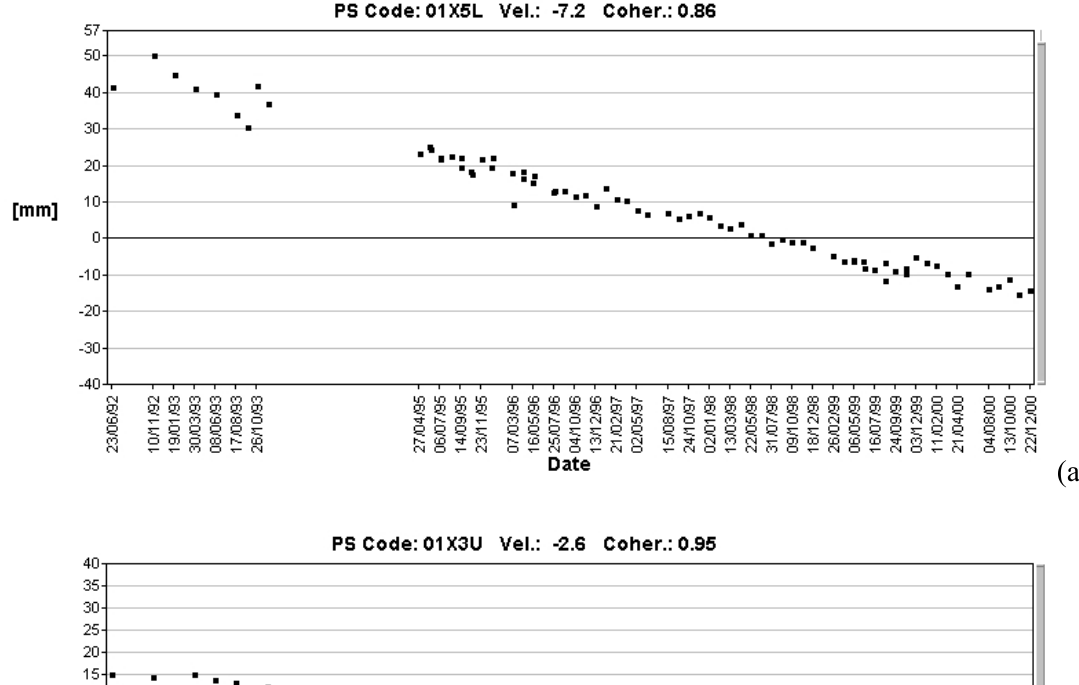
Figure 15. (a) PS LOS displacement series in correspondence of the highway. (b) PS LOS displacement series in correspondence of the lower sector of the Strona Stream alluvial fan. (c) PS LOS displacement series in correspondence of new buildings. For the location of PS LOS displacement series see Figure